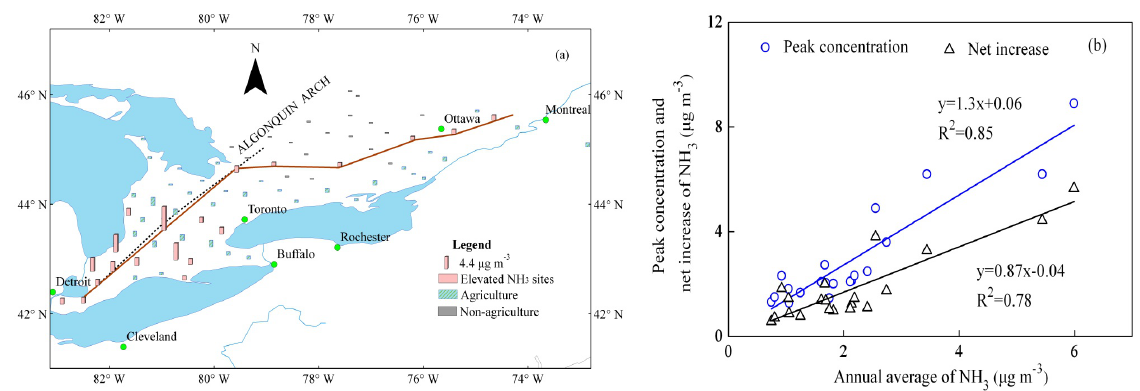
Fig. 8. (a) distribution of sites with elevated NH 3 in the coldest weeks, and (b) correlations between peak (or net increase) concentrations and annual averages for these